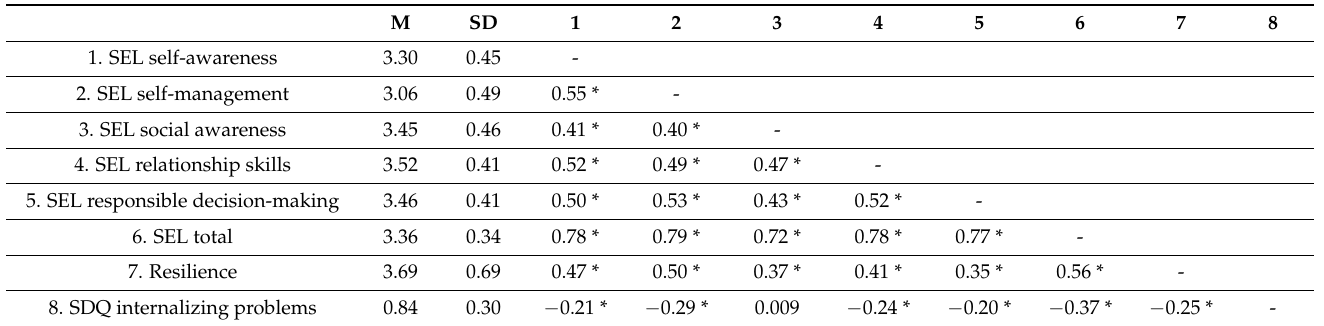
Table 1. Means and correlations between study’s